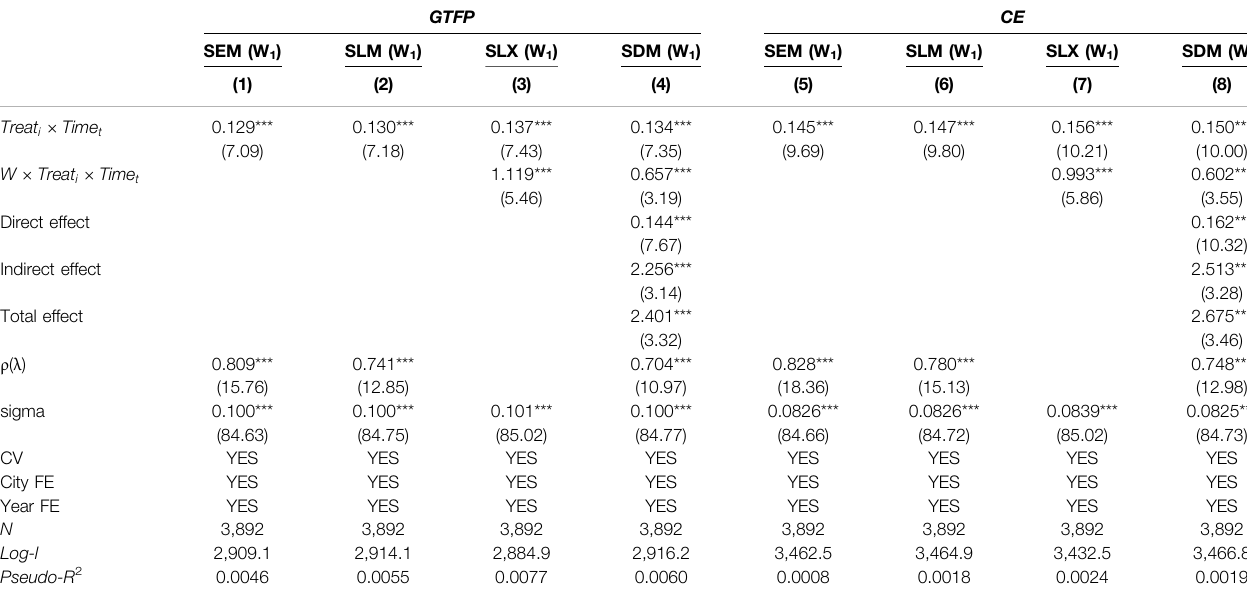
TABLE 5 | Estimates of the green and low-carbon development effects on sports